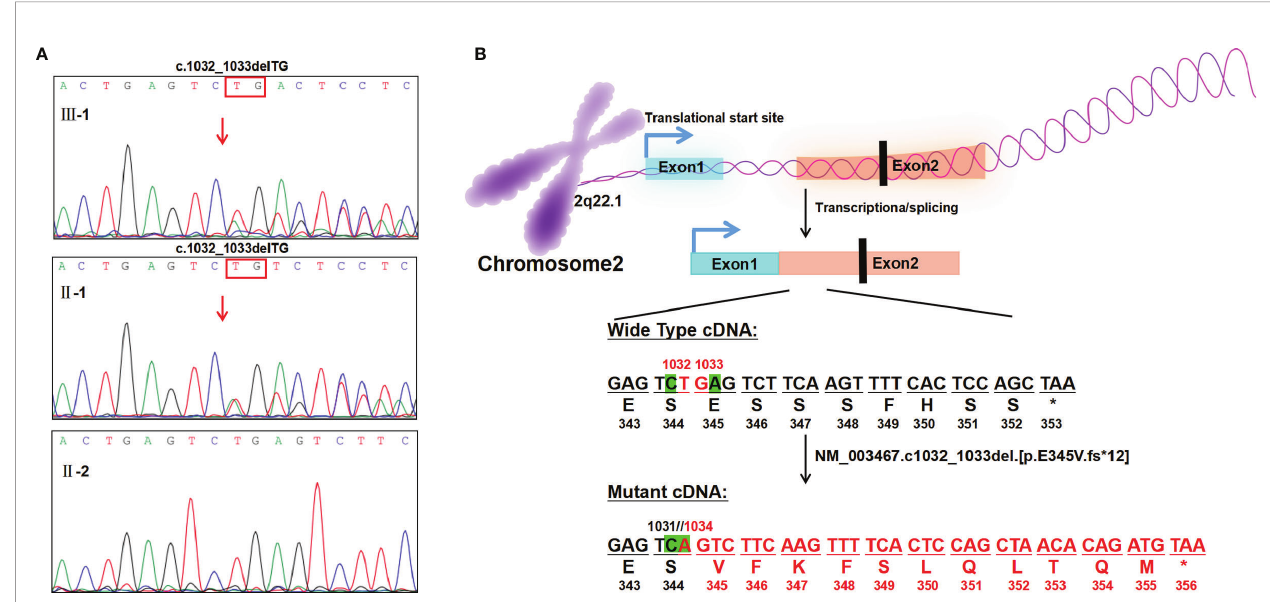
FIGURE 3 | Genetic analysis and illustration of the heterozygous c.1032_1033delTG mutation of CXCR4 gene. (A) Sanger sequencing of CXCR4 cDNA from the patient and his family, showing TG deletion from exon2(c.1032_1033del)in the proband and his father. The red arrow indicates the variant site of exon2. (B) Base deletion (exon2; NM_003467; c.1032_1033delTG) results in original stop-codon loss, frameshift, and prolonged